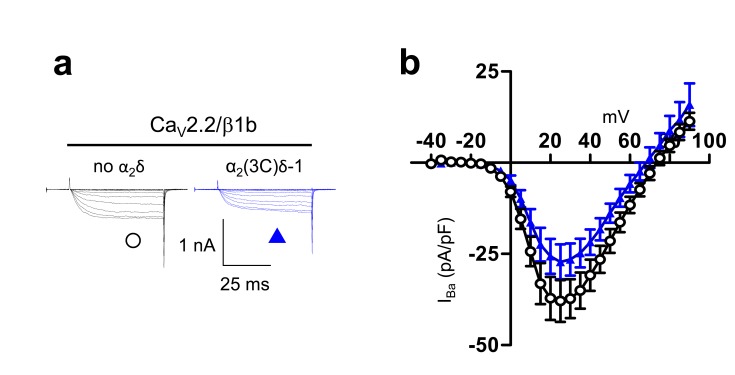
Examination of effect of α2(3C)δ-1 on CaV2.2/β1b calcium channel currents in tsA-201 cells.These experiments were performed using 10 mM Ba2+ to amplify any differences in current amplitude between the two conditions examined. (a) Example traces (−25 to +25 mV steps) for CaV2.2/β1b-GFP and either no α2δ (black traces) or α2(3C)δ-1 (blue traces). The scale bars refer to all traces. (b) Mean (± SEM) IV curves for experiments including those in (a), for CaV2.2/β1b-GFP and either no α2δ (black open circles, n = 10) or α2(3C)δ-1-HA (blue triangles, n = 14). Peak IBa at +25 mV was −37.9 ± 5.7 pA/pF and −27.2 ± 4.8 pA/pF, respectively. Gmax values were 0.91 ± 0.19 and 0.76 ± 0.12 nS/pF, respectively. V50,act values were 13.1 ± 1.6, and 14.9 ± 1.0 mV, respectively.